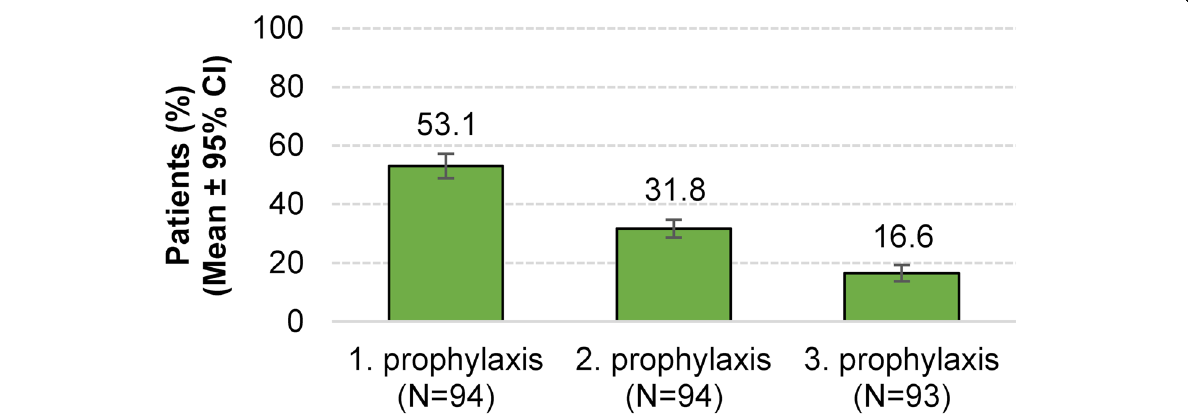
Fig. 3 Proportion of patients at distinct stages of prophylaxis at specialized centers in 2017/2018 ( n = number of questionnaires included in the evaluation)